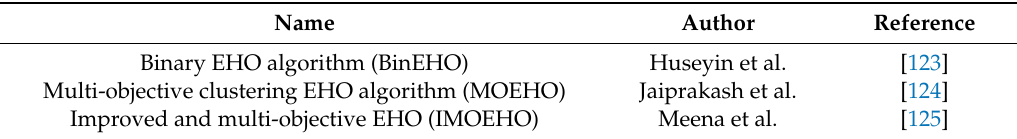
Table 3. Di ff erent variants of